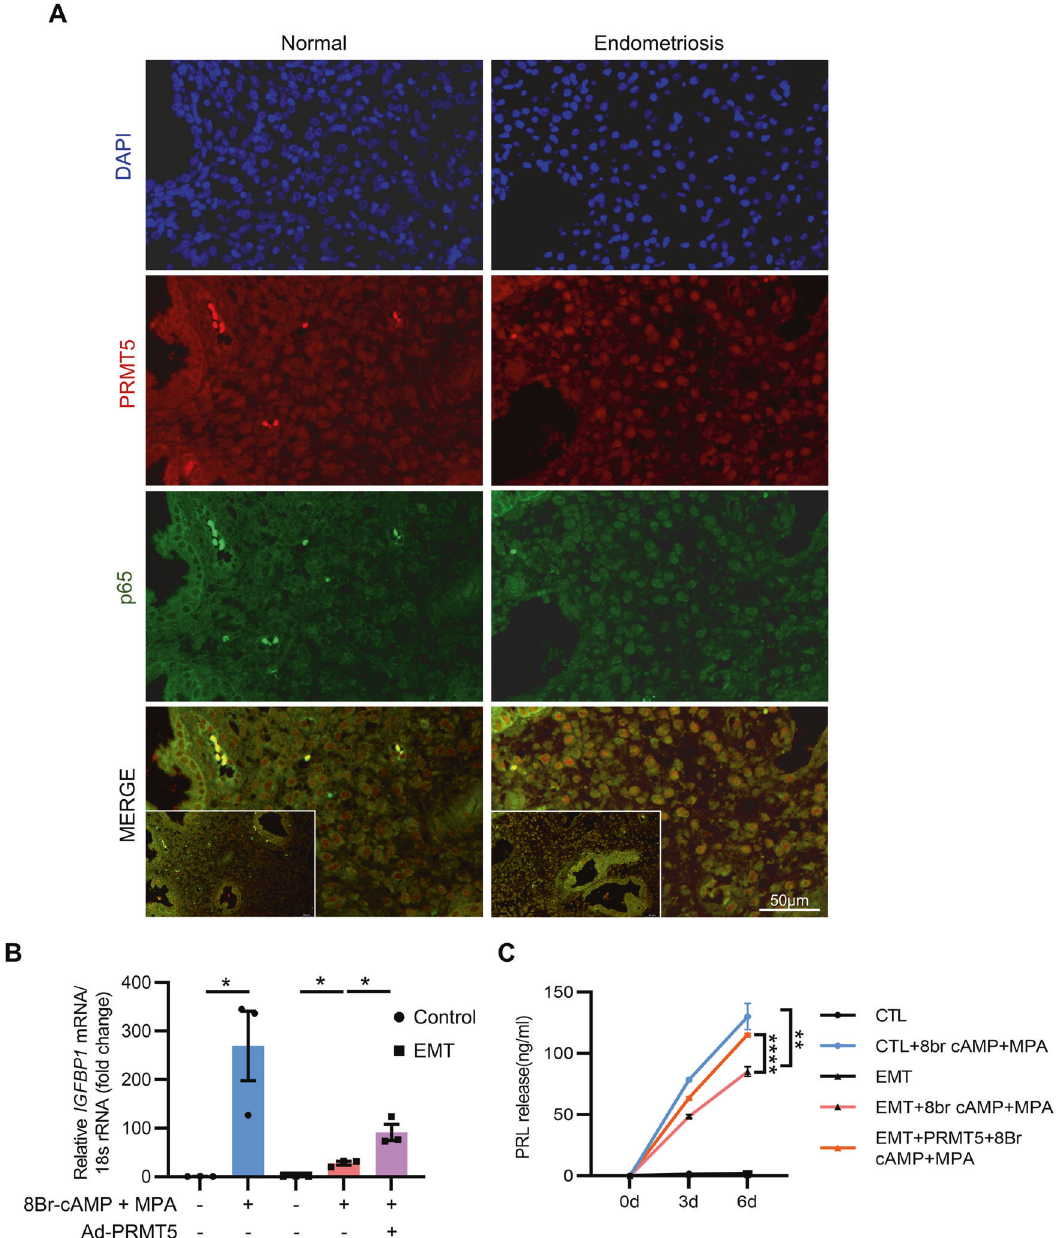
Fig. 7 PRMT5 rescues decidualization defects in endometrial stromal cells from endometriosis patients. A Analysis of the immuno fl uorescence staining of p65 and PRMT5 in mid-secretory phase eutopic endometrium from women with or without endometriosis, scale bar = 50 µm. B qRT – PCR analysis of IGFBP1 mRNA in hEnSCs from endometriosis patients infected with Ad-PRMT5 for 24 h before 3 days of treatment with 8Br-cAMP and MPA. C ELISA results of PRL levels in the supernatant obtained from hEnSCs of endometriosis patients decidualized for 3 and 6 days followed by infection with Ad-PRMT5. Means ± SEM. * P < 0.05, ** P < 0.01, **** P < 0.0001, One-way ANOVA with Tukey ’ s multiple comparisons test in B , Two-way ANOVA with Tukey ’ s correction for multiple comparisons in C